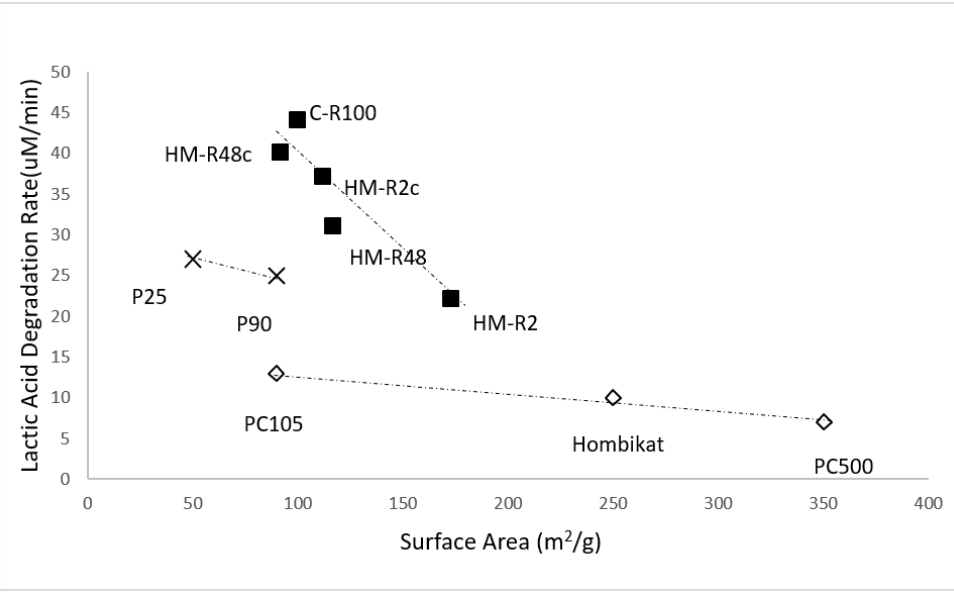
Figure 3. Impact of the surface area on LA degradation in the presence of rutile TiO 2 (filled square), anatase TiO 2 (diamond) and mixed anatase rutile phase (cross).